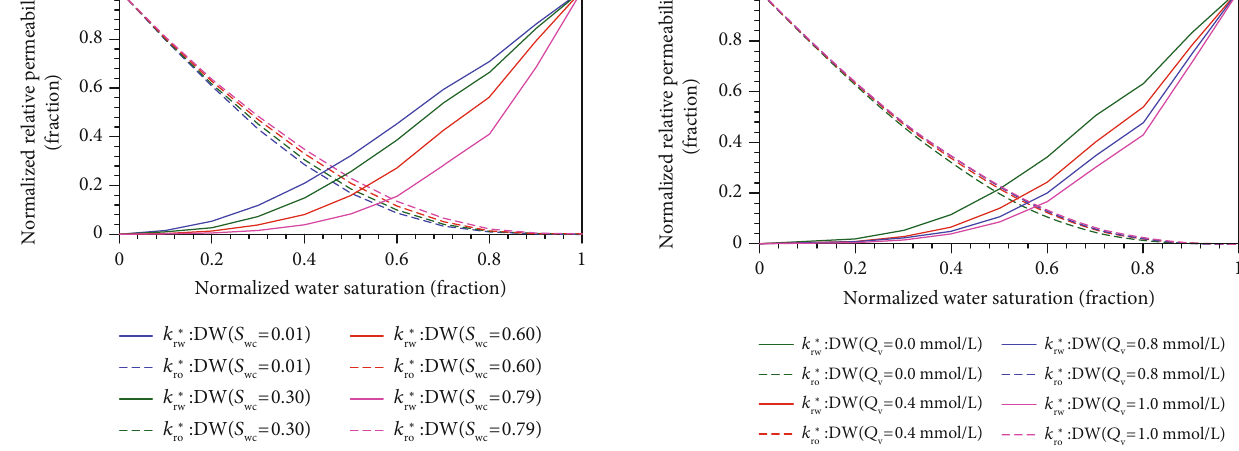
Figure 2: Normalized oil-water relative permeability curves under di ff erent S wc .